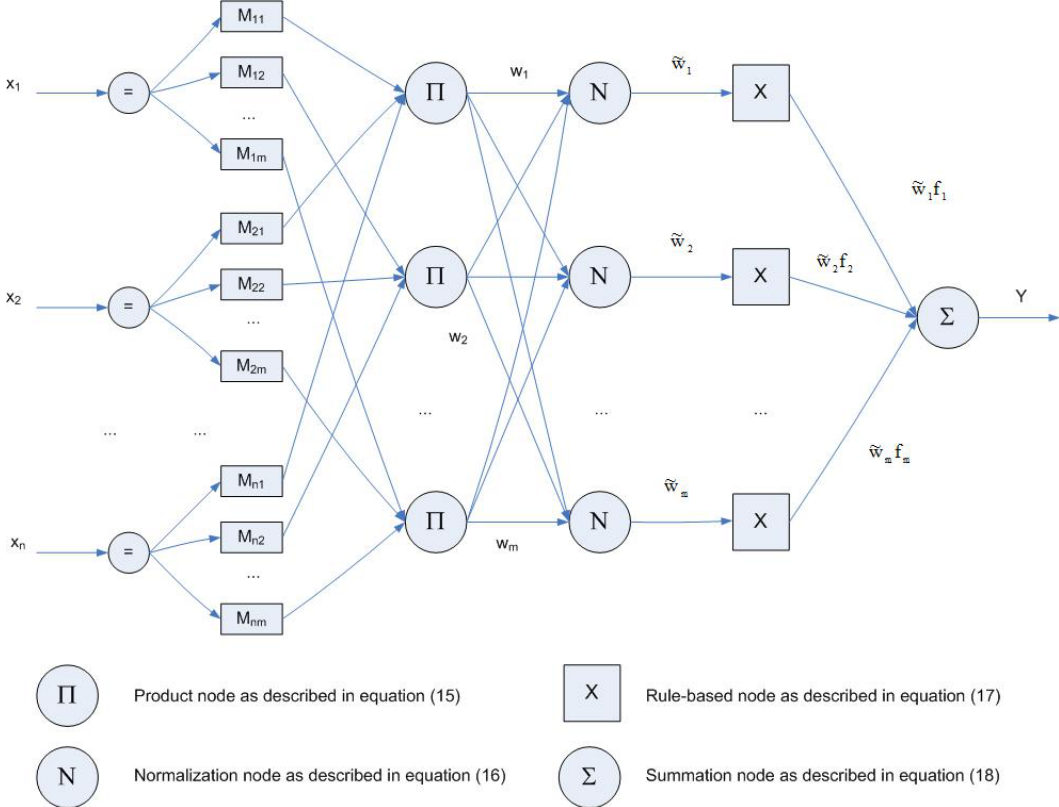
Figure 7. Structure of a fuzzy-neural